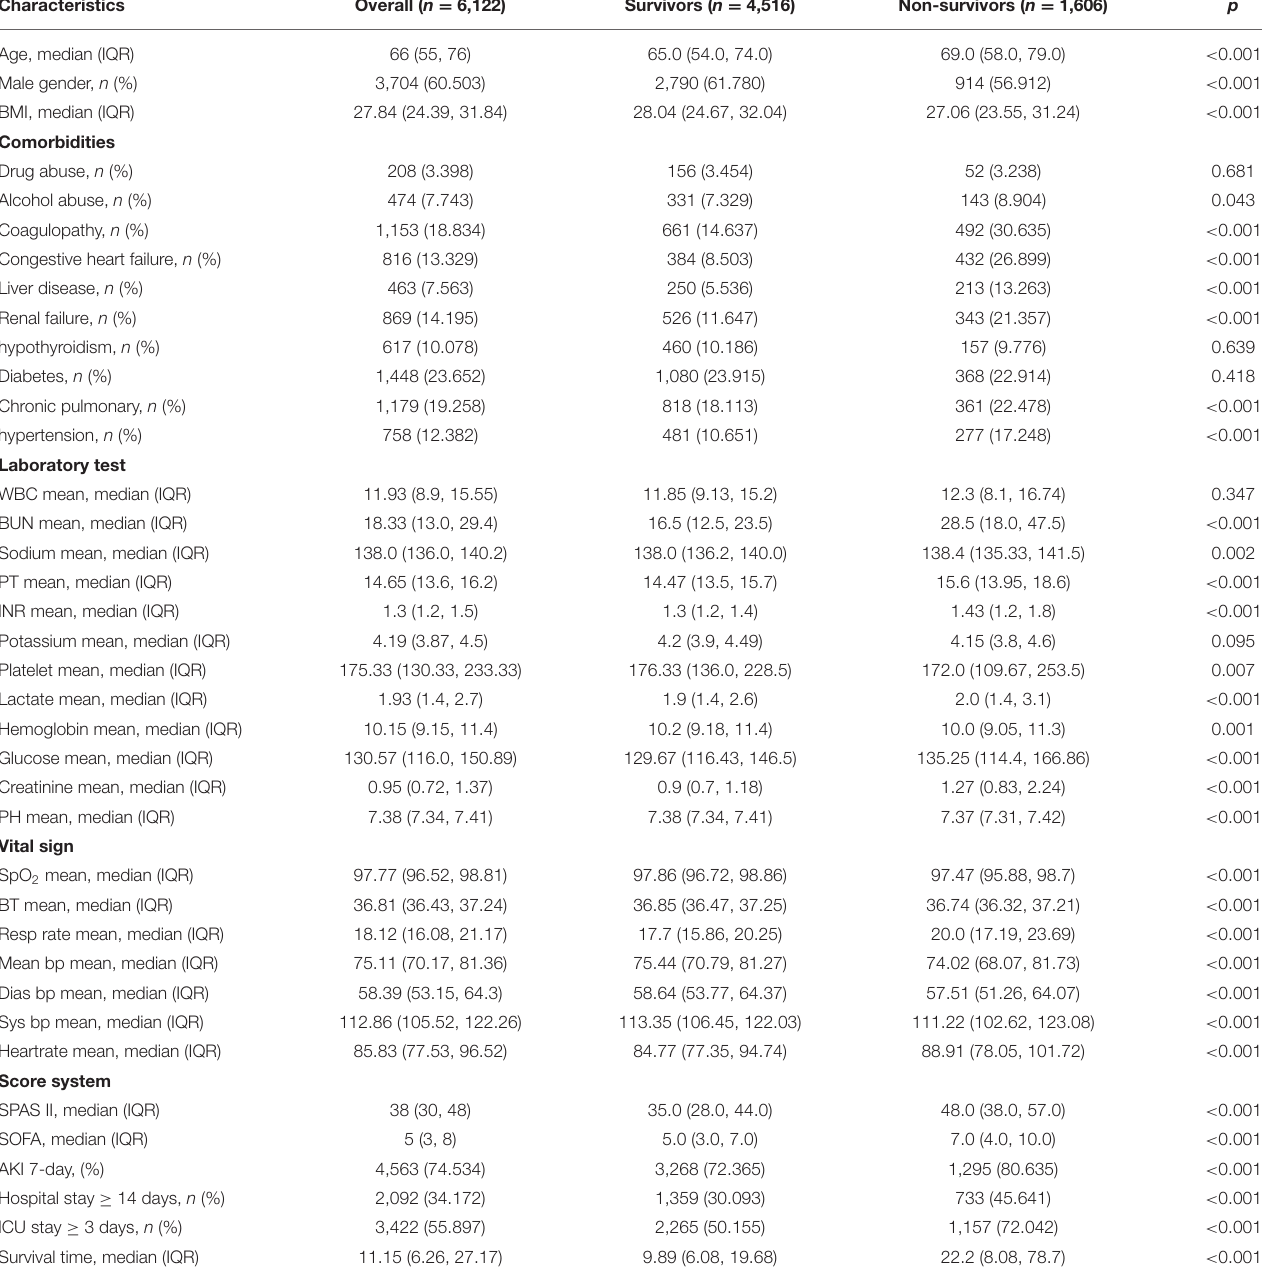
TABLE 1 | Baseline clinical characteristics between survivors and non-survivors at 1 year. Characteristics